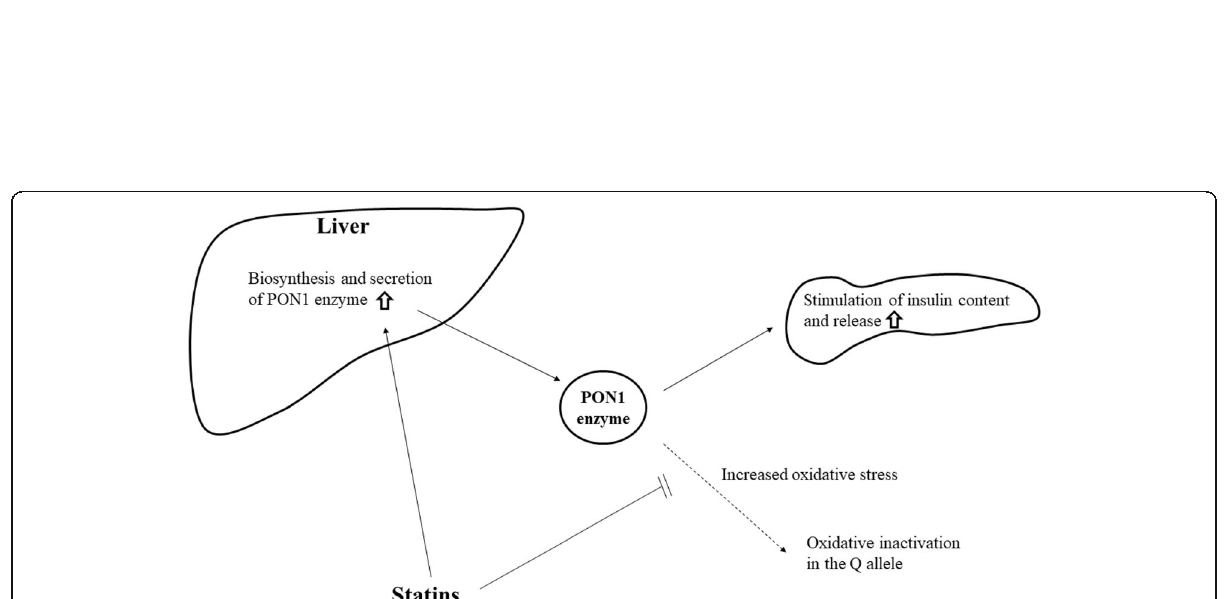
Fig. 2 Proposed model for the interaction of PON1 Q192R polymorphism and statins on insulin